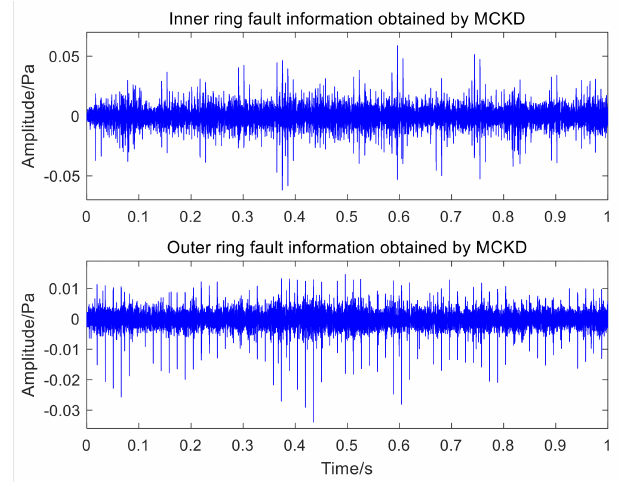
Figure 16. The time-domain waveform of an acoustic signal processed by MCKD.